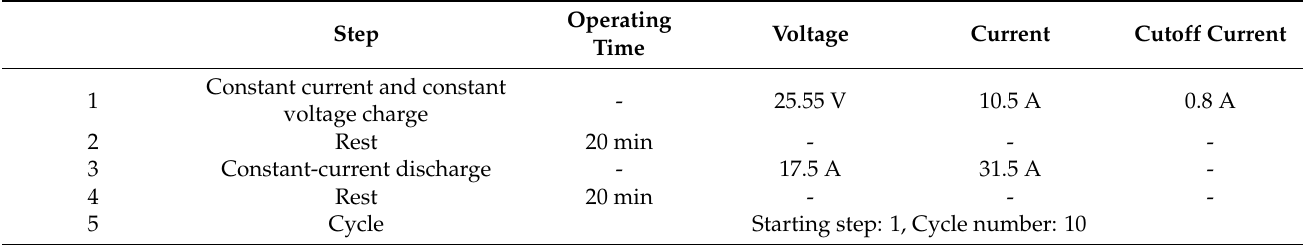
Figure 4. A schematic diagram of the experimental test platform. Table 3. Detailed parameters of the charge-discharge protocols of a battery module.